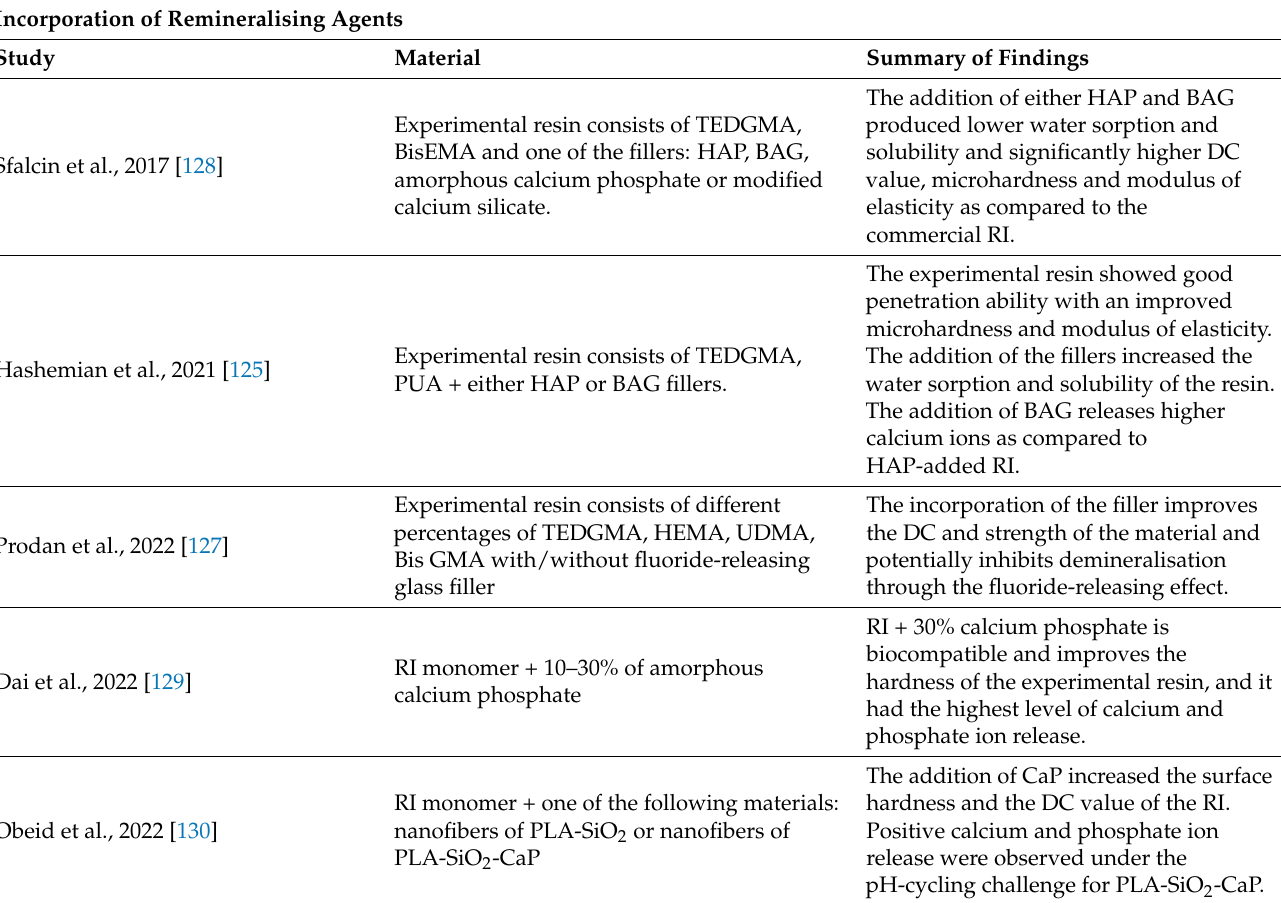
Table 4. Summary of the main laboratory-based studies conducted to improve the current